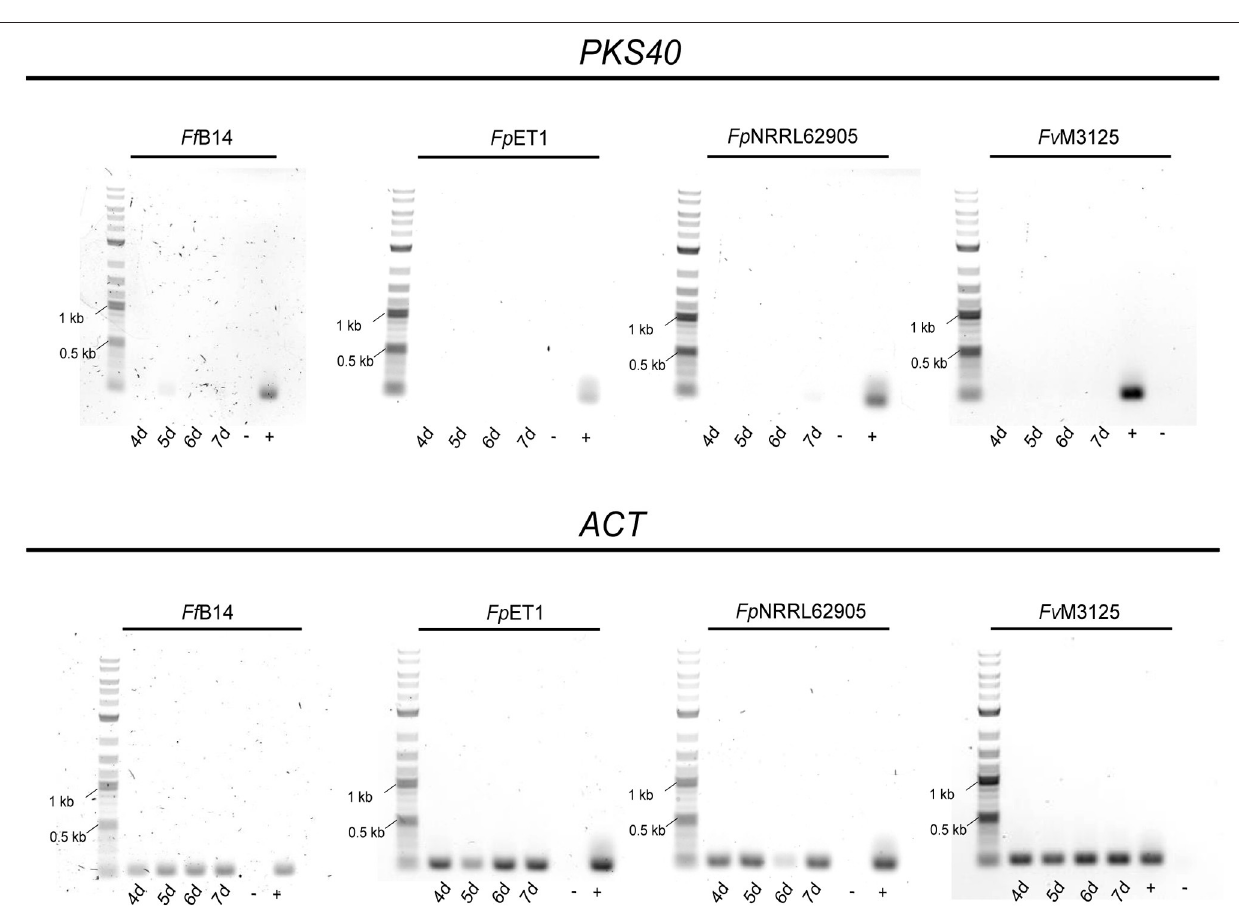
FIGURE 10 | Semi-quantitative gene expression analysis of PKS40 in other members of the FFSC. The respective Fusarium strains were cultivated for 4–7 days in FPY-inducing conditions. Subsequently, RNA extraction and cDNA synthesis were performed. Gene expression was tested with the primer pair FfPKS40_F//FmPKS40_R for the indicated Fusarium species. As cDNA control the housekeeping gene actin was amplified using the primers Actin_F//R. As size marker the GeneRuler 1kb Plus DNA Ladder (NEB) was used. As positive control ( + ) respective Fusarium sp. gDNA was used, while as negative control (-) sterile water was